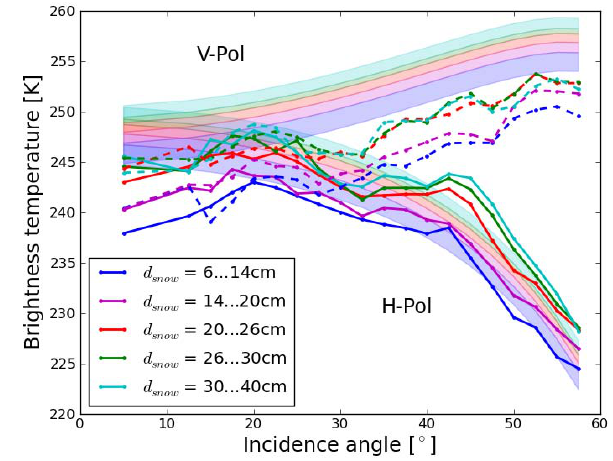
Fig. 6. Brightness temperatures averaged over the incidence angle range 0–60 ◦ as simulated (solid line) and as observed by SMOS (dashed line) at horizontal (reddish colors) and at vertical (bluish colors) polarisation vs. the average snow thickness of the snow thickness classes 1–5. For the SMOS observations, the error bars indicate the average standard deviation of the different incidence angle ranges. For the simulations, the error bars indicate the mod- elled brightness temperature range for the range of snow thicknesses contained within each class.